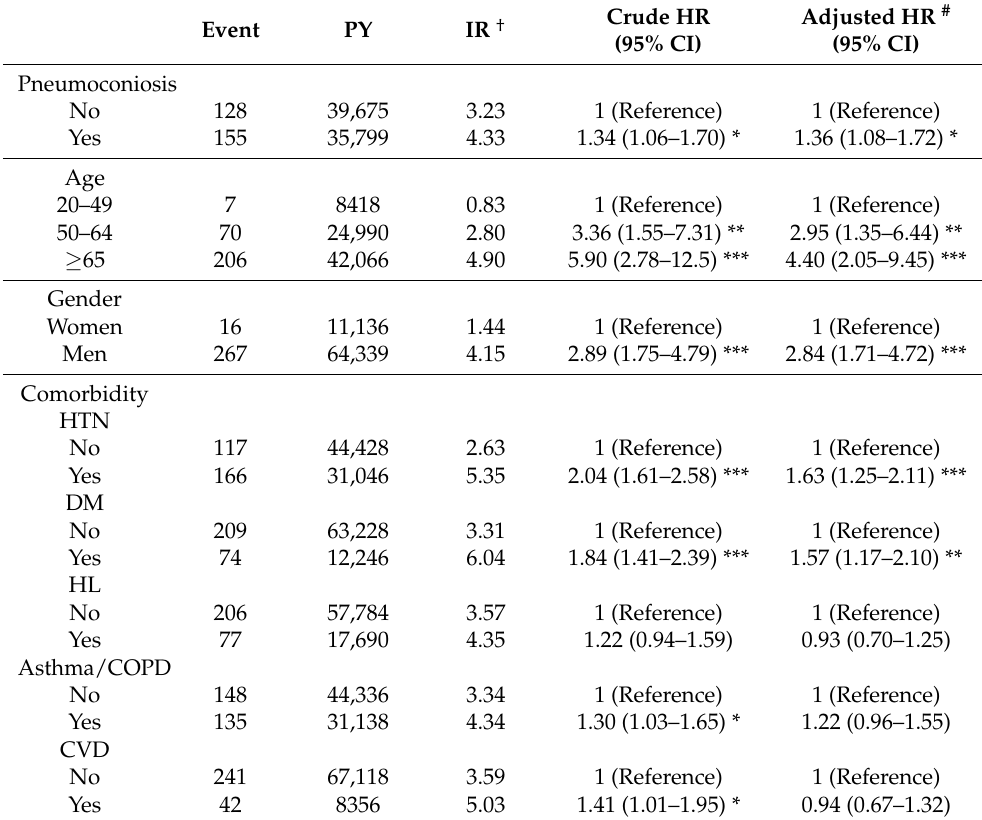
Table 2. Risk factors of acute myocardial infarction among the study participants.